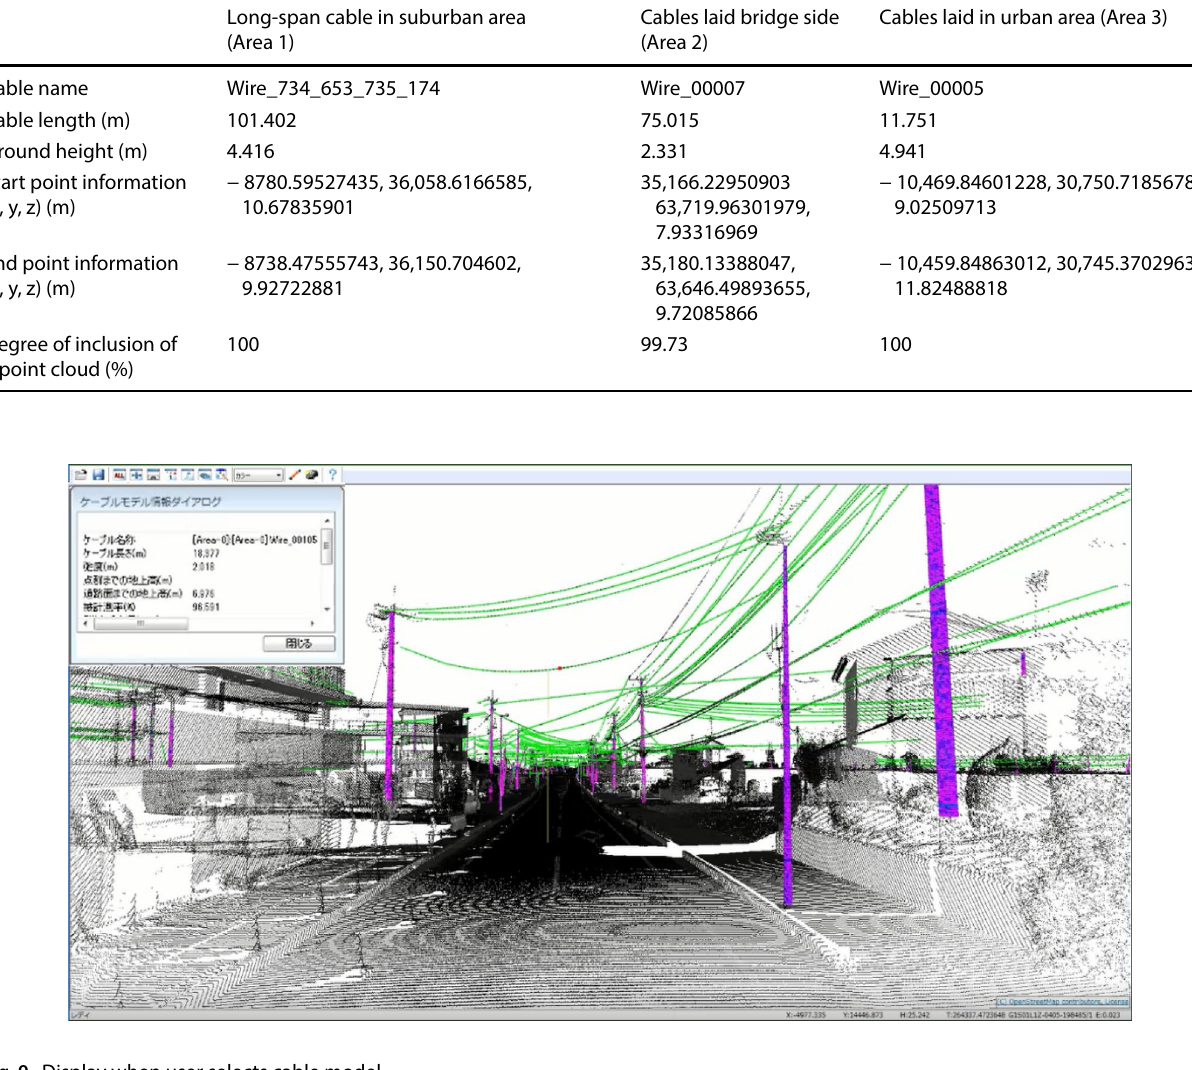
Fig. 9 Display when user selects cable